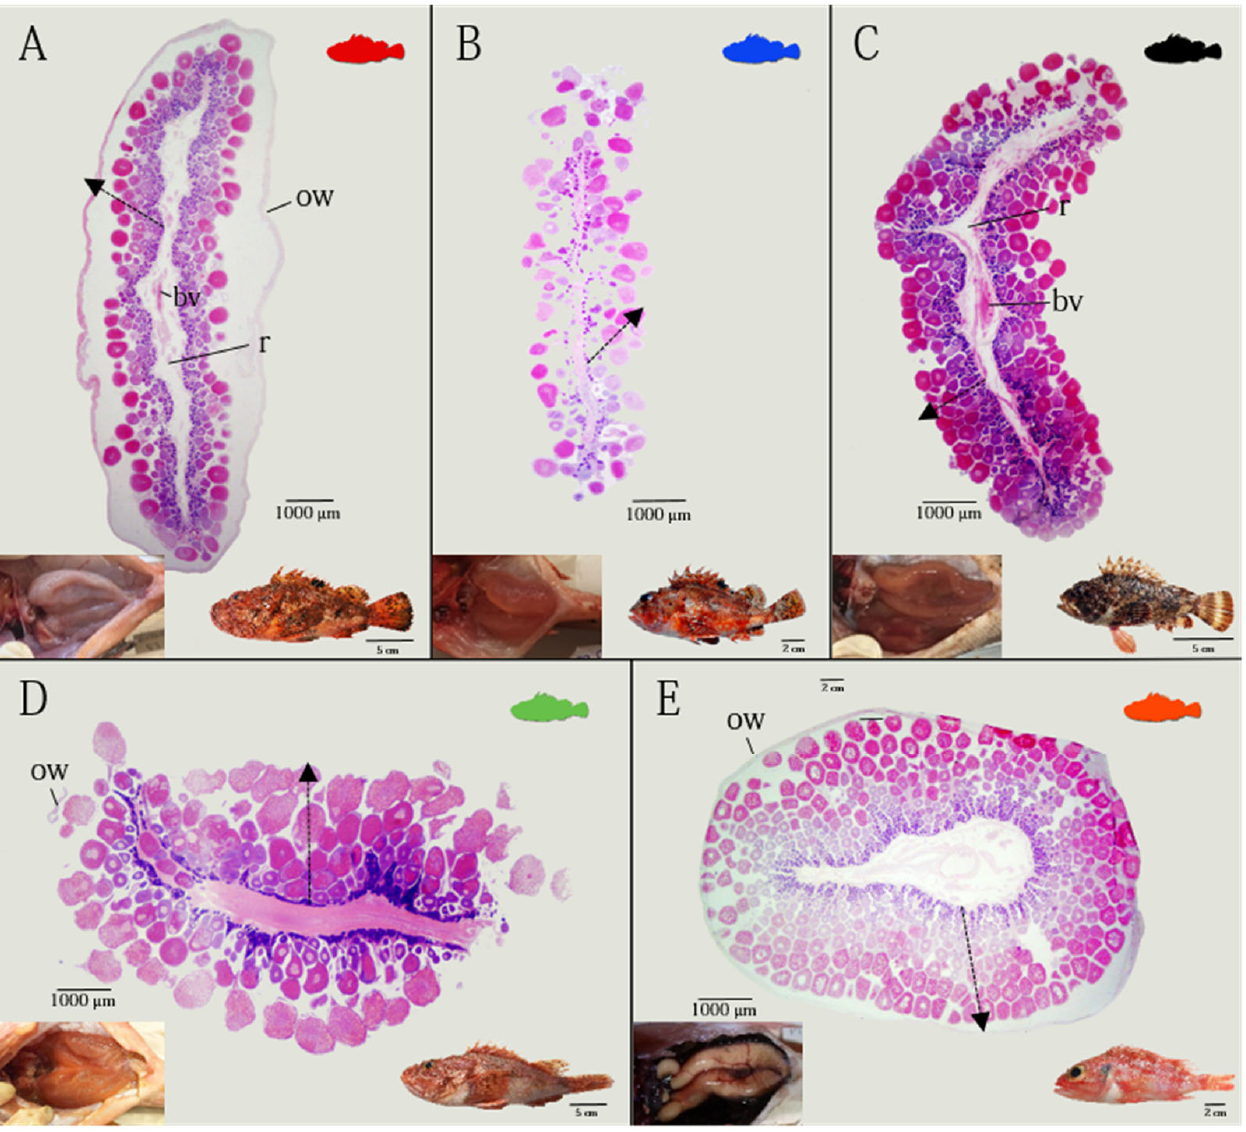
Figure 1. Morphological characteristics of cystovarian type II ‐ 3 ovary of the five species studied (H&E). Corresponding macroscopic ovaries, located in the abdominal cavity above the bladder, are also shown down on the left of each species. ( A ) Scorpaena scrofa (TL 22.3 cm); ( B ) Scorpaena notata (TL 11.3 cm); ( C ) Scorpaena porcus (TL 15.6 cm); ( D ) Scorpaena elongata (TL 28.7 cm); ( E ) Helicolenus dactylopterus (TL 18.2 cm). bv, blood vessel; ow, ovarian wall; r, rachis. The dashed line shows the radial development of oocytes from the stroma to surrounding ovarian wall.